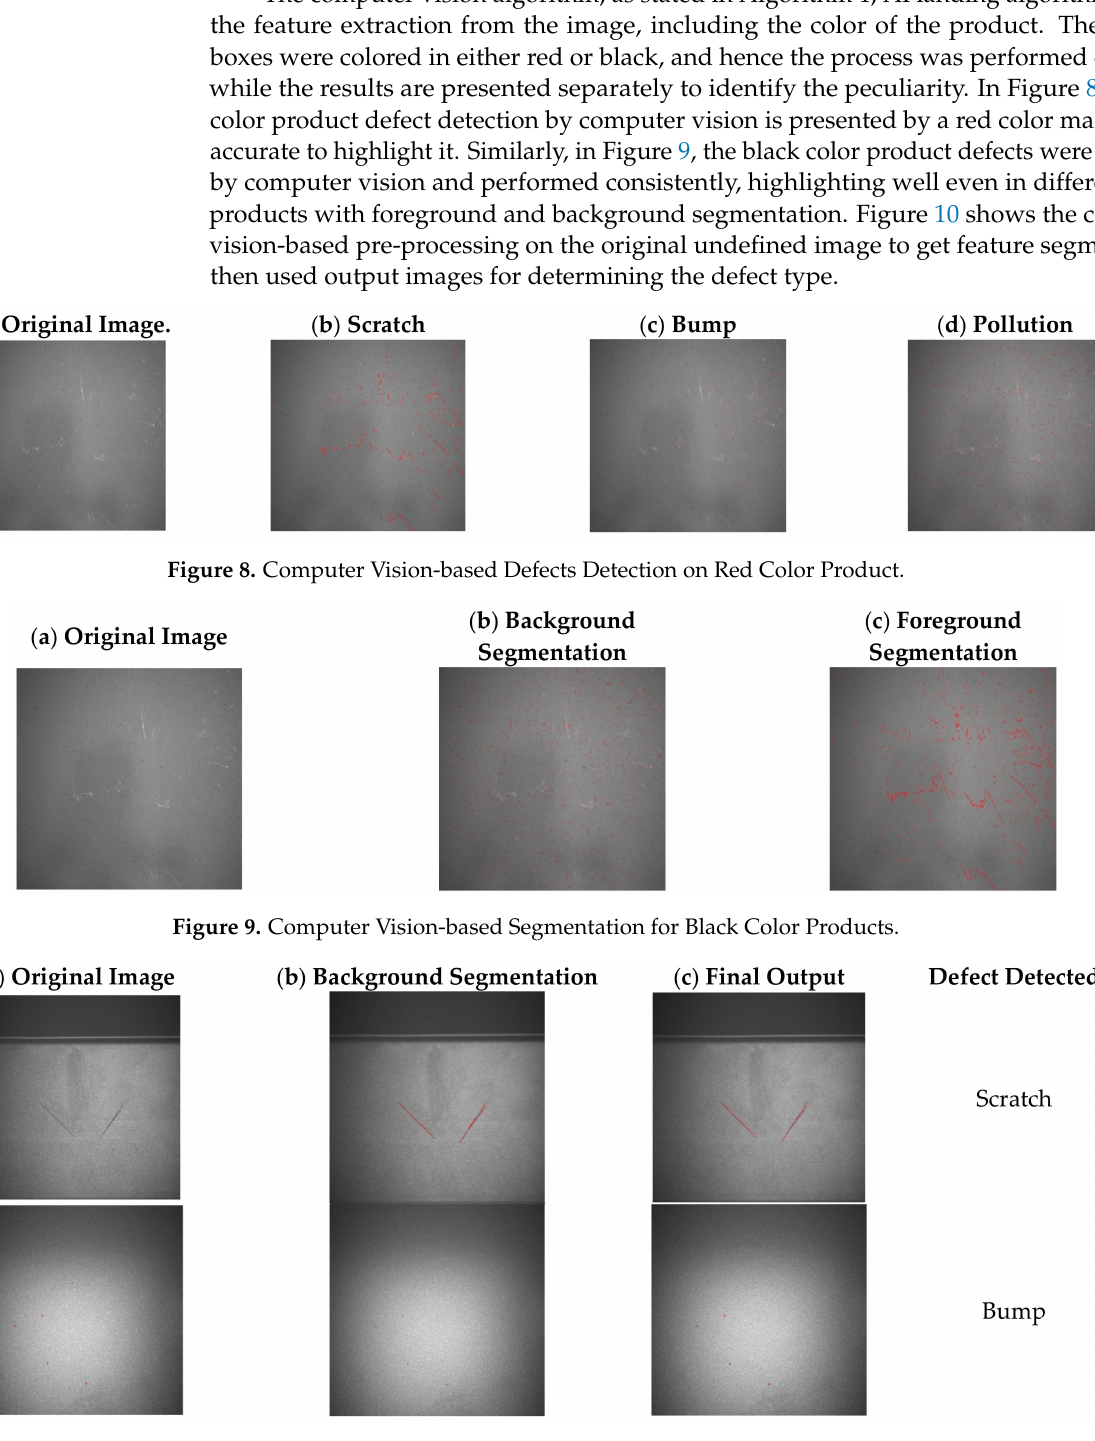
Figure 10. Computer Vision-based Evaluation for Black Color